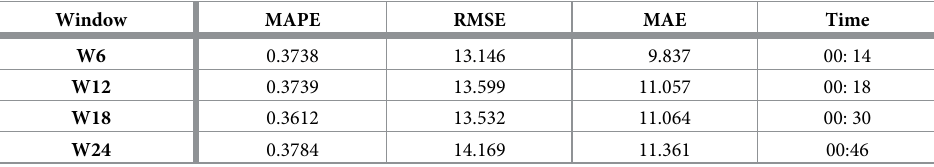
Table 3. Results of using various moving window sizes